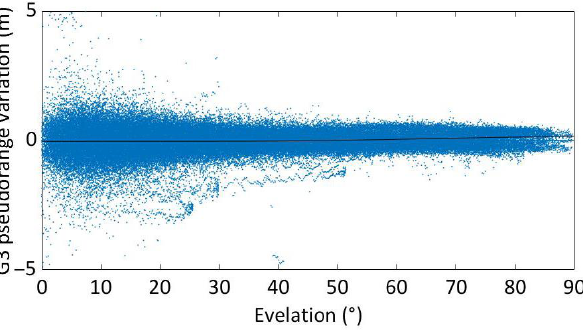
Figure 6. Relationship between the code pseudorange variations and the elevation angle of R21 on DOY 325, 2020.